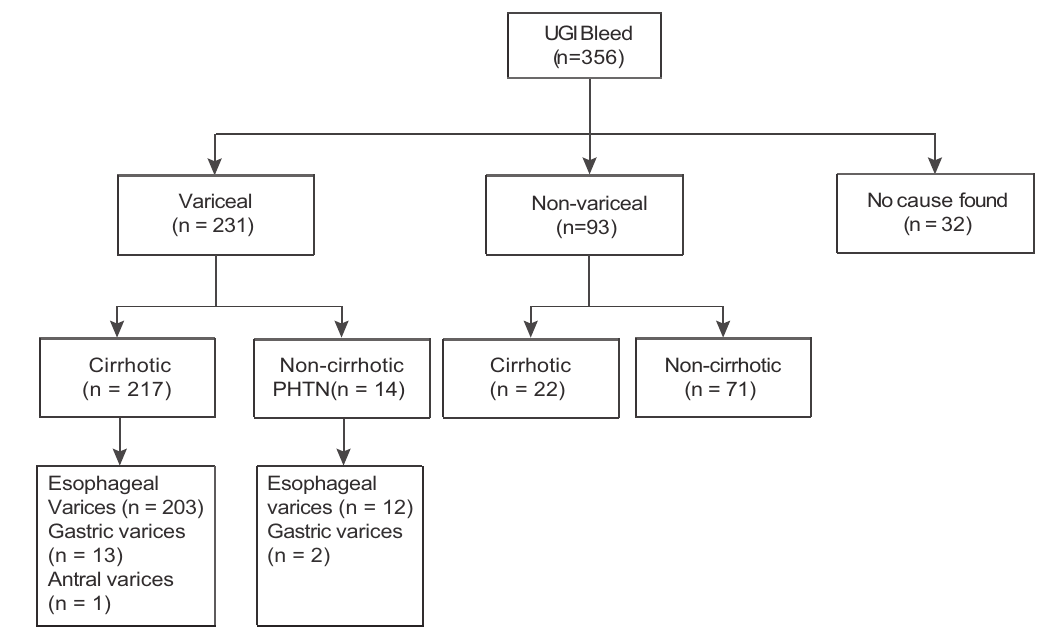
Figure 1: Distribution of variceal and nonvariceal causes of upper GI